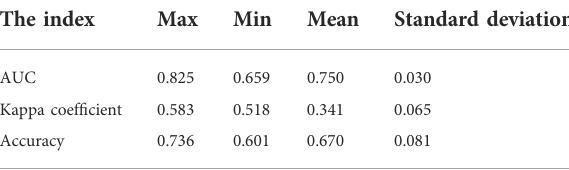
TABLE 4 Logistic regression model training results (30 times).